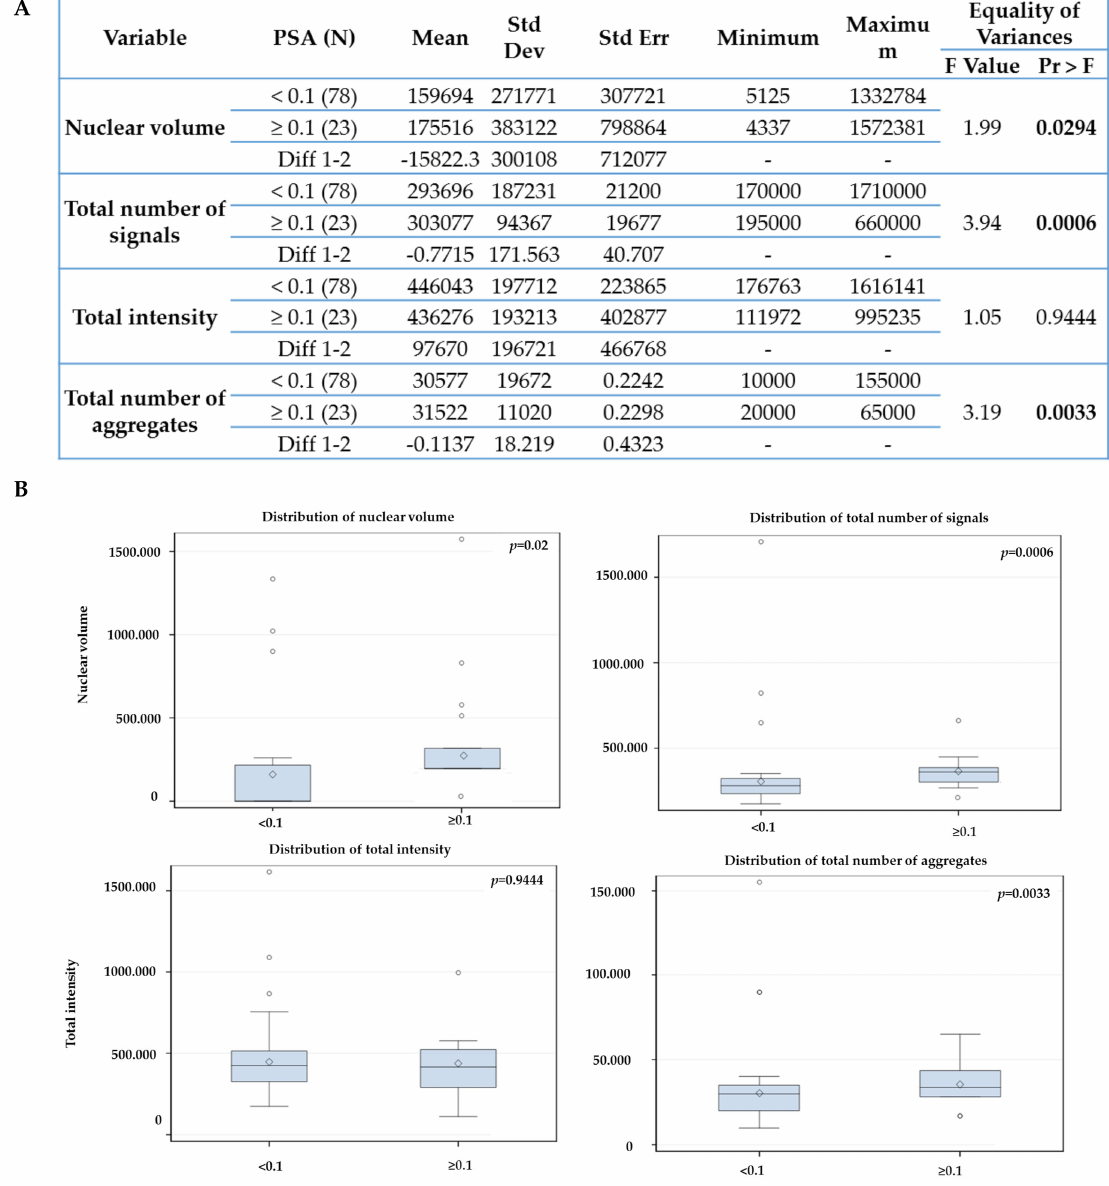
Figure 5. Statistical analysis comparing the telomeres parameters at 0m with PSA end value at 6 months after radiotherapy using 0.1 ng / mL cuto ff ( A ). ( B ) Box-plots generated by Statistical Analysis Software v. 9.4. The box is divided in the following way: —the median is the middle line, the 50th percentile- the top of box is the 75th percentile- the bottom box is the 25th percentile. Concerning the whiskers, the upper top of whiskers represent the max observation 1.5 × (interquartile range (IQR)—75th percentile minus 25th percentile), while the bottom of whiskers represent the minimum observation 1.5 × (1QR from 25th). The observations plotted are outliers—beyond the 1.5 × IQR or below. The sign in the box is the mean. The box indicates where 50 percent of the observations lies, extending to the whiskers indicates where most of the data lies and the points outside are